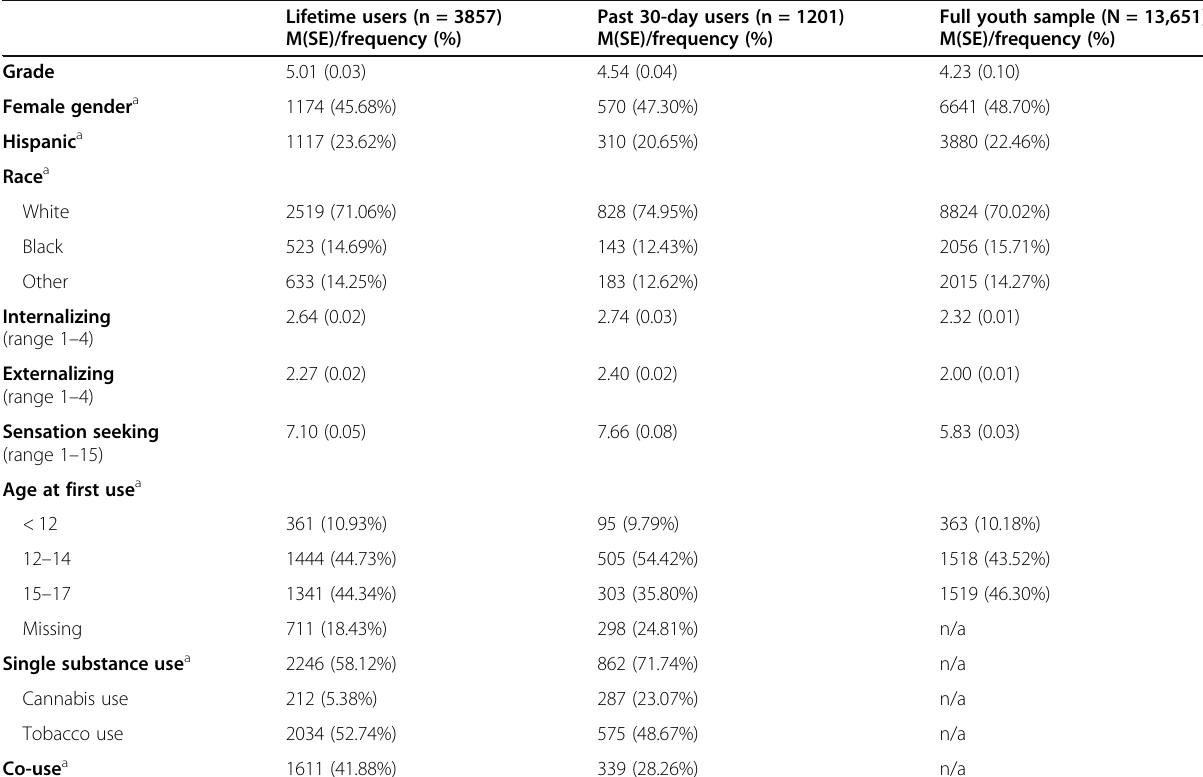
Table 2 Lifetime, past 30-day, and full youth sample (including non-users) demographics, psychological constructs (sensation- seeking, internalizing, and externalizing), age at first use, and tobacco and cannabis use and co-use